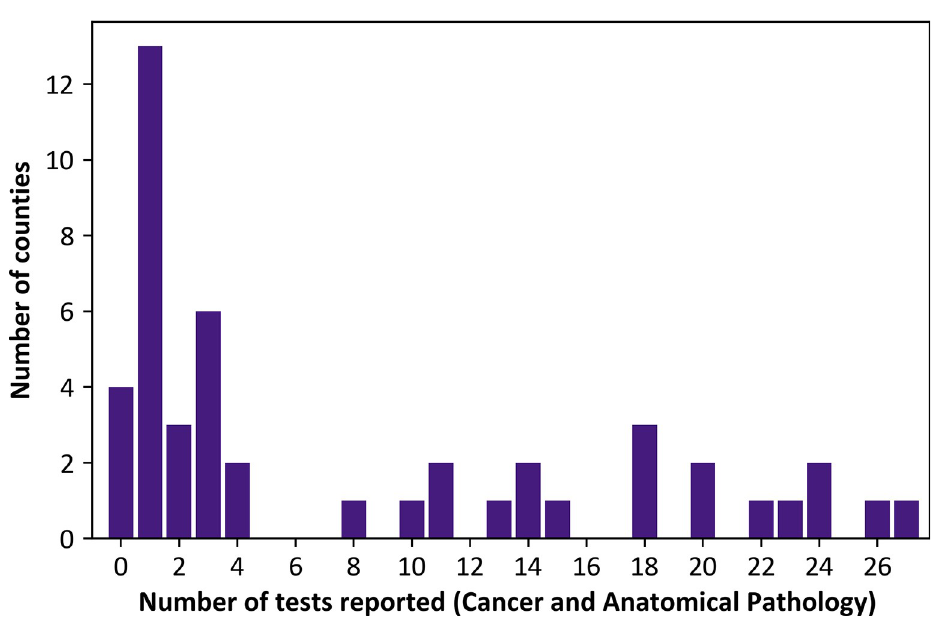
Fig 7. Number of cancer and anatomical pathology tests ever reported within county hospitals in the year 2018 and